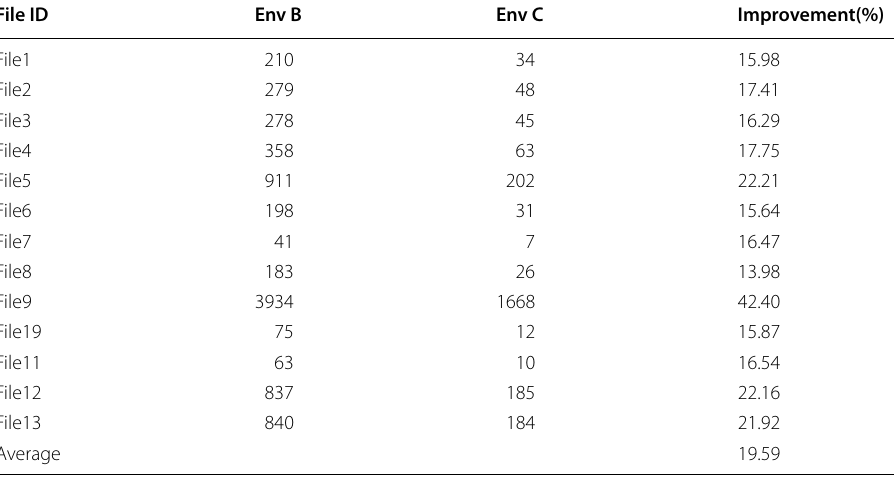
Table 6 Improvement of (in seconds) for different BIM data (in ML time